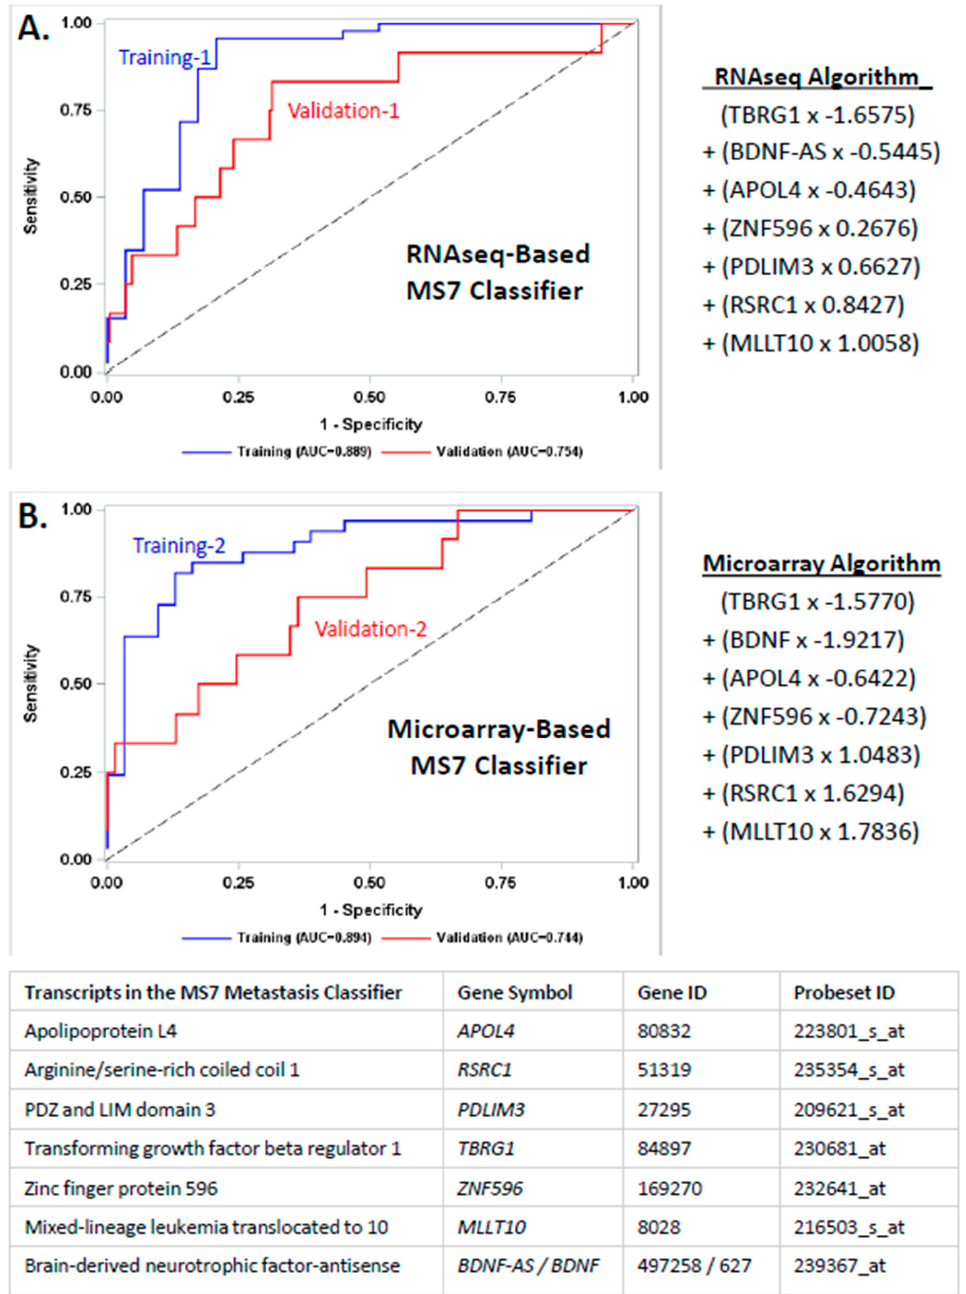
Figure 1. Received operator characteristic (ROC) curves for the sensitivity and 1-specificity for prediction of nodal and distant metastasis using the RNAseq-based MS7 score in the Training-1 cohort (blue line) and the Validation-1 (red line) cohort ( A ) or using the microarray-based MS7 score in the Training-2 cohort (blue line) or the Validation-2 (red line) cohort ( B ). The MS7 score integrated transcript expression data for apolipoprotein L4 (APOL4), myeloid/lymphoid or mixed-lineage leukemia translocated to 10 (MLLT10), PDZ and LIM domain 3 (PDLIM3), arginine/serine-rich coiled coil 1 (RSRC1), transforming growth factor beta regulator 1 (TBRG1), zinc finger protein 596 (ZNF596), and brain-derived neurotrophic factor antisense (BDNF-AS) using the platform-centric algorithms. The formula that was used to calculate the RNAseq algorithm and the microarray algorithm are provided to the right of the ROC curves. The Gene ID and Affymetrix probe set ID are incorporated for each transcript in the table insert below panel B. (cid:3041) 𝑀𝑆7 𝑅𝑖𝑠𝑘 𝑆𝑐𝑜𝑟𝑒 𝑓𝑜𝑟 𝑀𝑒𝑡𝑎𝑠𝑡𝑎𝑠𝑖𝑠 (cid:3404) (cid:3533) (cid:4666)𝑡𝑟𝑎𝑛𝑠𝑐𝑟𝑖𝑝𝑡 𝑒𝑥𝑝𝑟𝑒𝑠𝑠𝑖𝑜𝑛 𝑖 𝑥 𝑐𝑜𝑒𝑓𝑓𝑖𝑐𝑖𝑒𝑛𝑡 𝑖(cid:4667) (cid:3036)(cid:2880)(cid:2869)